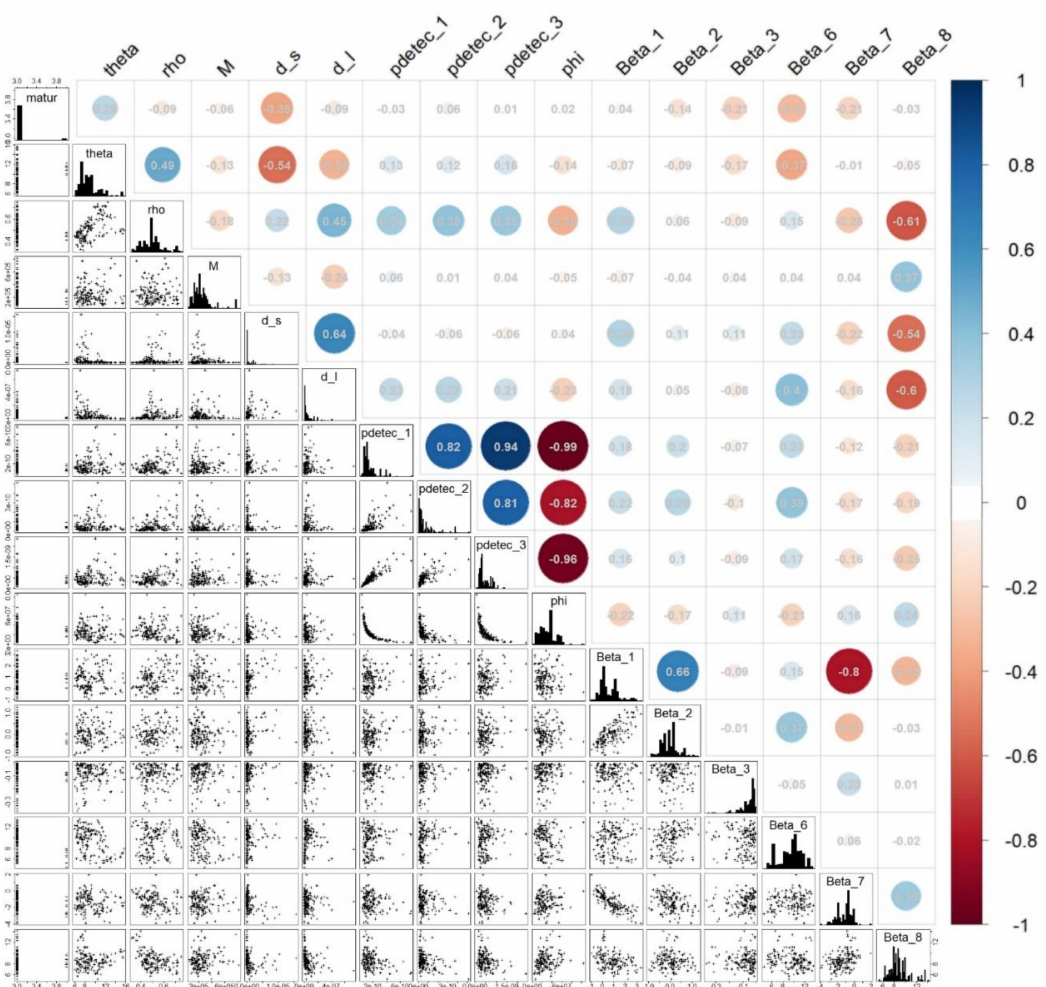
Figure A7. Scatterplots and Pearson correlations between pairs of model parameters across samples of the 9 chains of the last MCMC